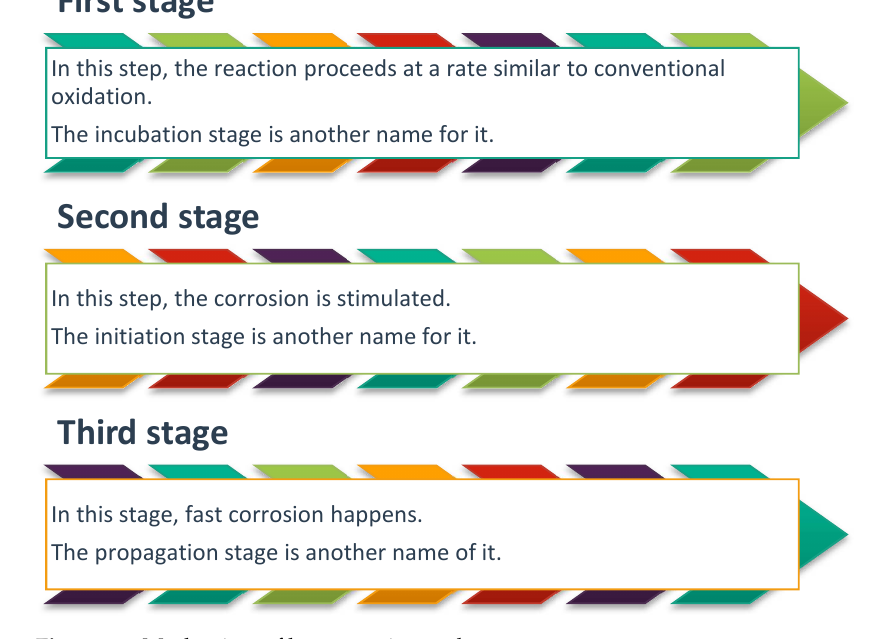
Figure 21. Preventative strategies to combat the hot-corrosion effects at high temperatures.